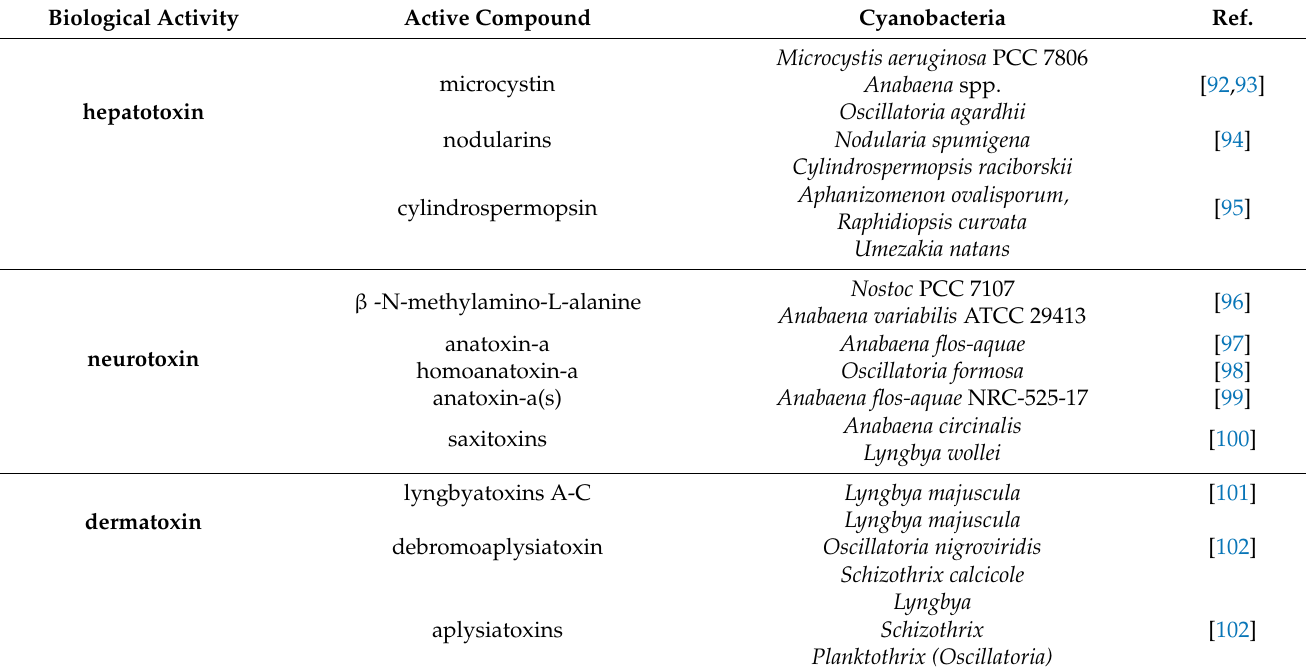
Table 2. Cyanobacterial